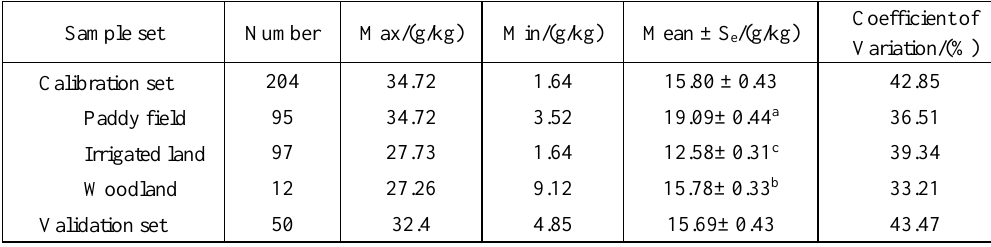
Table 2. Descriptive statistics of SOC content for different land use